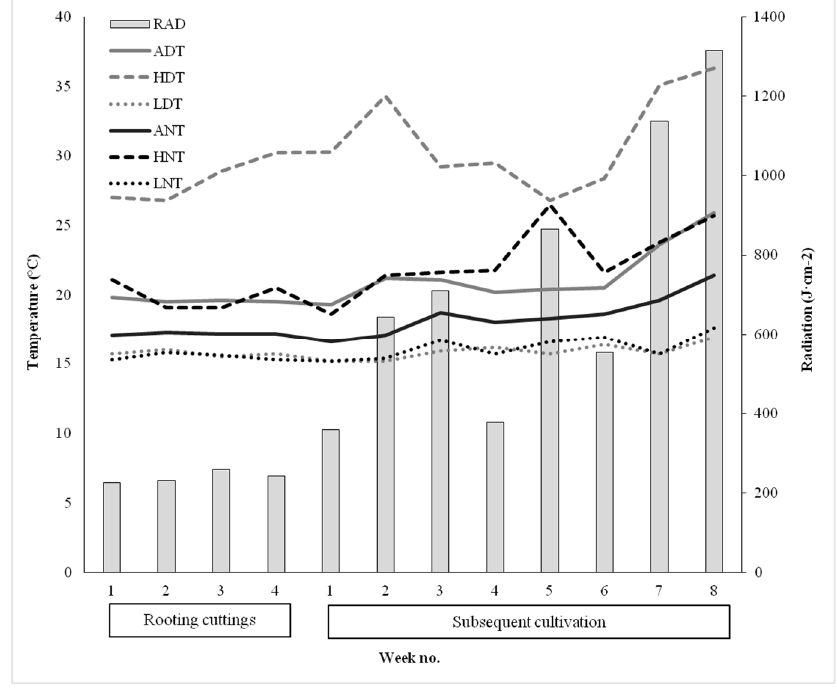
Figure 1. Weekly radiation (RAD) as well as weekly average day temperature (ADT), highest day temperature (HDT), lowest day temperature (LDT), average night temperature (ANT), highest night temperature (HNT), lowest night temperature (LNT) during the